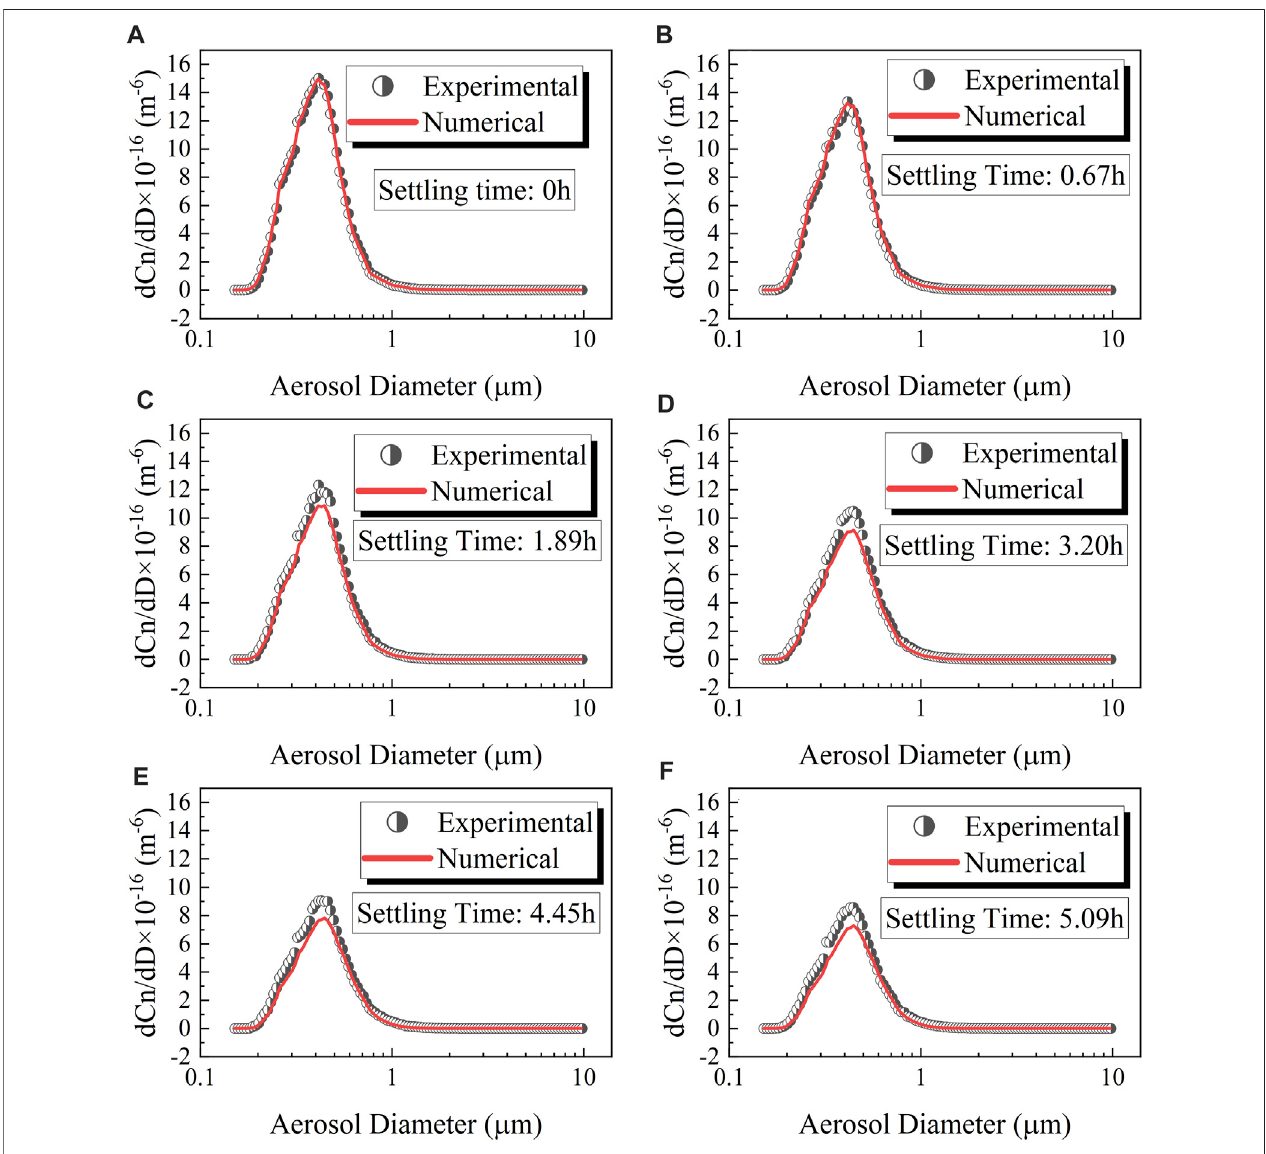
FIGURE 8 | Comparison of the experimental and numerical size distribution of the aerosol at different time, the dynamic shape factor x = 4: (A) 0 h, (B) 0.67 h, (C) 1.89 h, (D) 3.20 h, (E) 4.45 h and (F) 5.09 h.